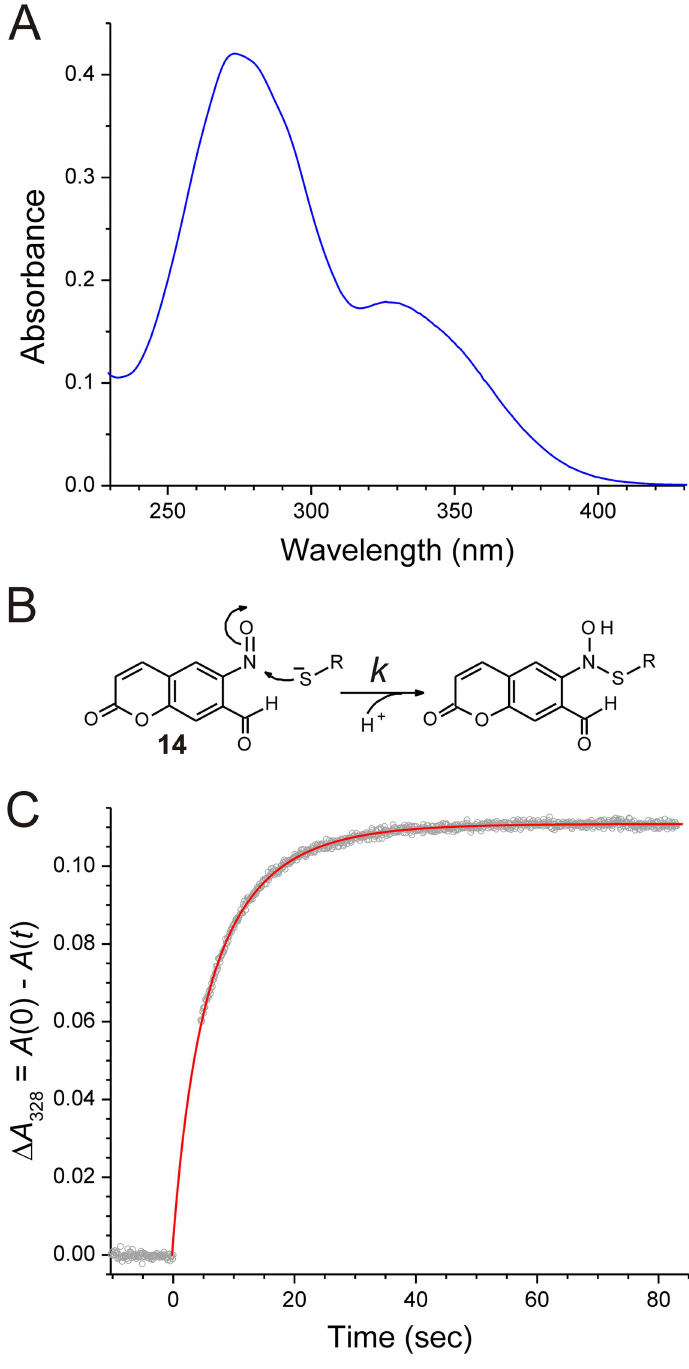
Fig 8. Nitroso photoproduct of the Ncm cageand its reaction with glutathione. (A) UV-visible spectrum of a 30 μ Msolutionof 7-formyl-6-nitrosocoumarin ( 14 )in 10 mM sodiumphosphatebuffer (pH 7). (B) Schematic representation of the reaction of 14 with a thiolate(RS – ), whichaddsnucleophilically to the nitrosogroup,and concomitantly disruptsthe chromophore.The bimolecularrate constantis k . (C) Spectrophotometrically monitored time courseof the reactionof 14 (25 μ M)with glutathione(50 μ M)in 10 mM sodiumphosphatebuffer (pH 7.0, 24˚C). Grey circlesare experimental data acquiredat 20 Hz; red curve is the nonlinearleast-squares fit þ S ½ 1 þ ð e (cid:0) k app t (cid:0) 2 Þ (cid:0) 1 (cid:138) , where k app = 0.5[GSH] 0 k , ( k is the bimolecular rate constant to the function, y ¼ y 0 indicatedin panelB, and the initialglutathioneconcentration is [GSH] 0 = 50 μ M),and y 0 and S are adjustable parameters (see Materialsand Methods and S1 Text for details).For the data set shown, k = 3.74 × 10 3 M -1 s -1